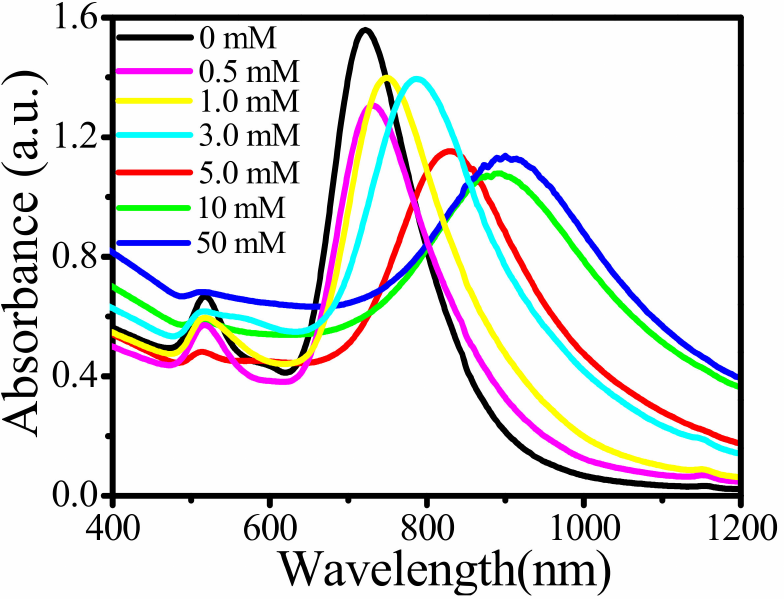
Figure 2. Absorption spectra of the Au NRs and the Au-tipped Pt NRs with concentrations of Pt ions of 0, 0.5, 1, 3, 5, 10 and 50